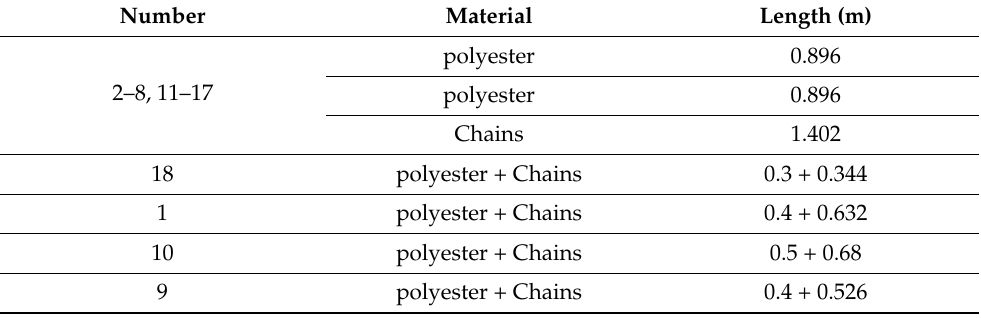
Figure 18. Y-type mooring line.